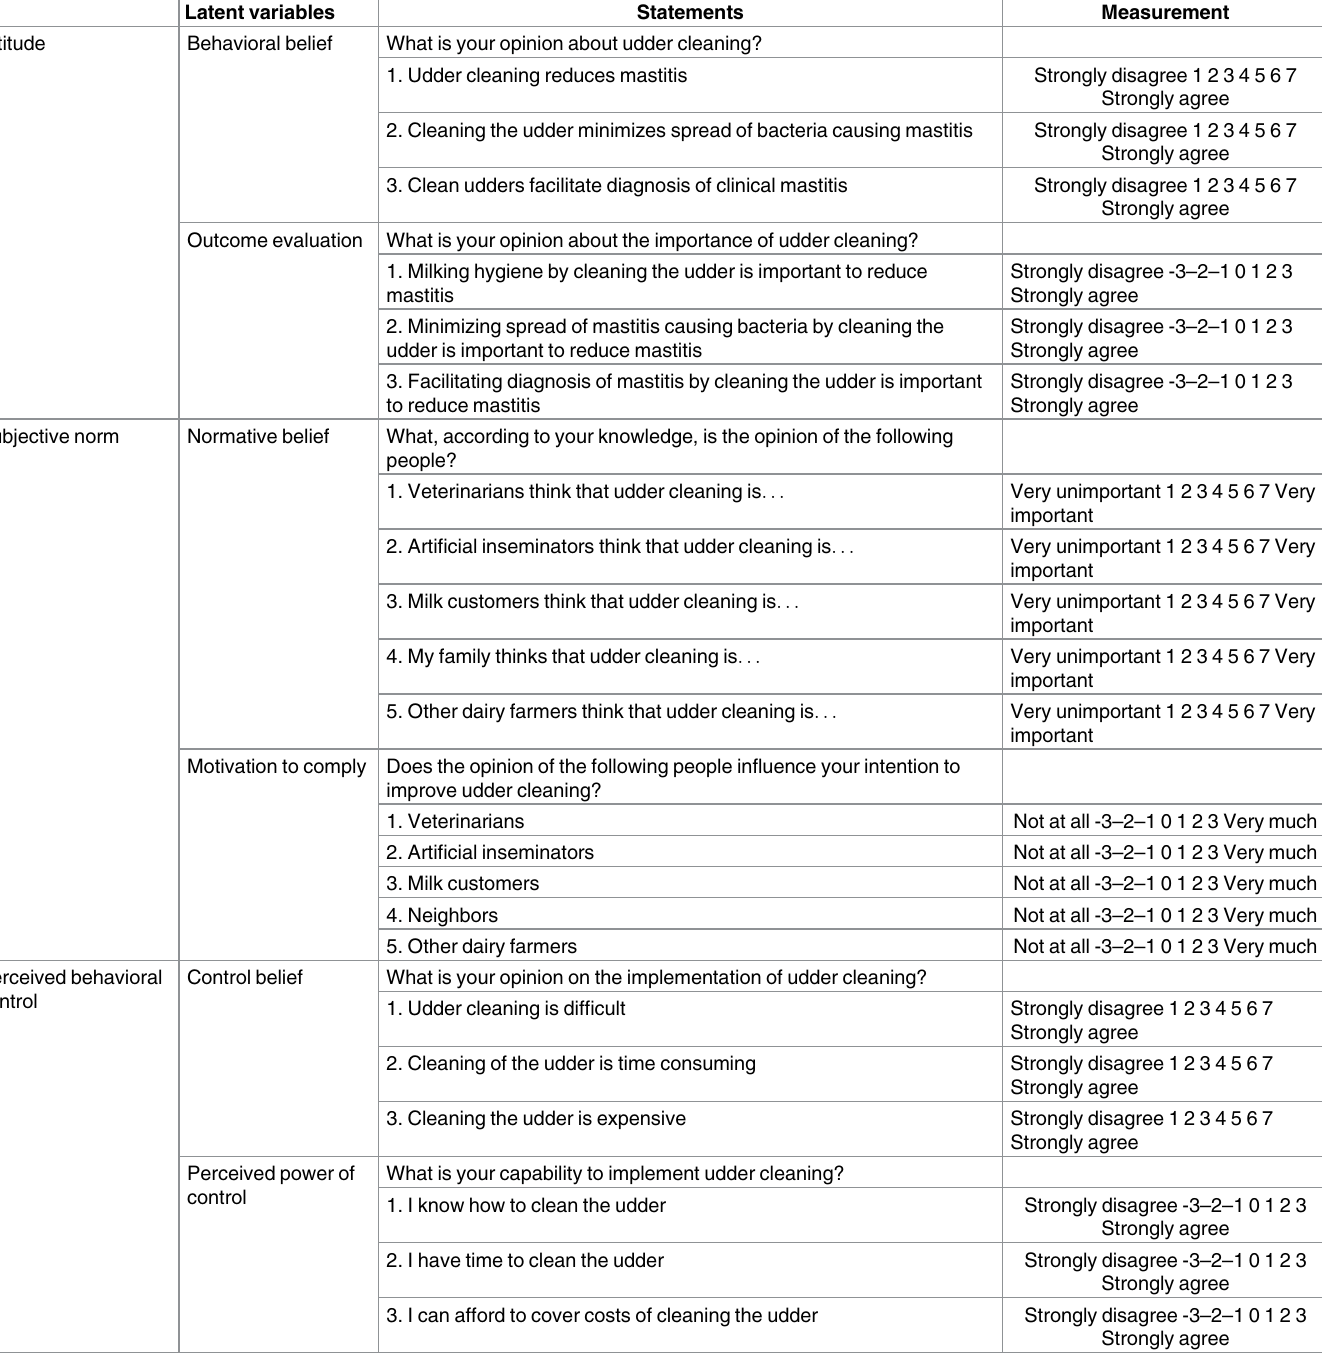
Table 2. Statements used to measurebehavioral, normative and control beliefs and outcome evaluation, motivation to comply and perceived power of control for udder cleaning on 134 North-Western Ethiopian dairy farmers. Latent